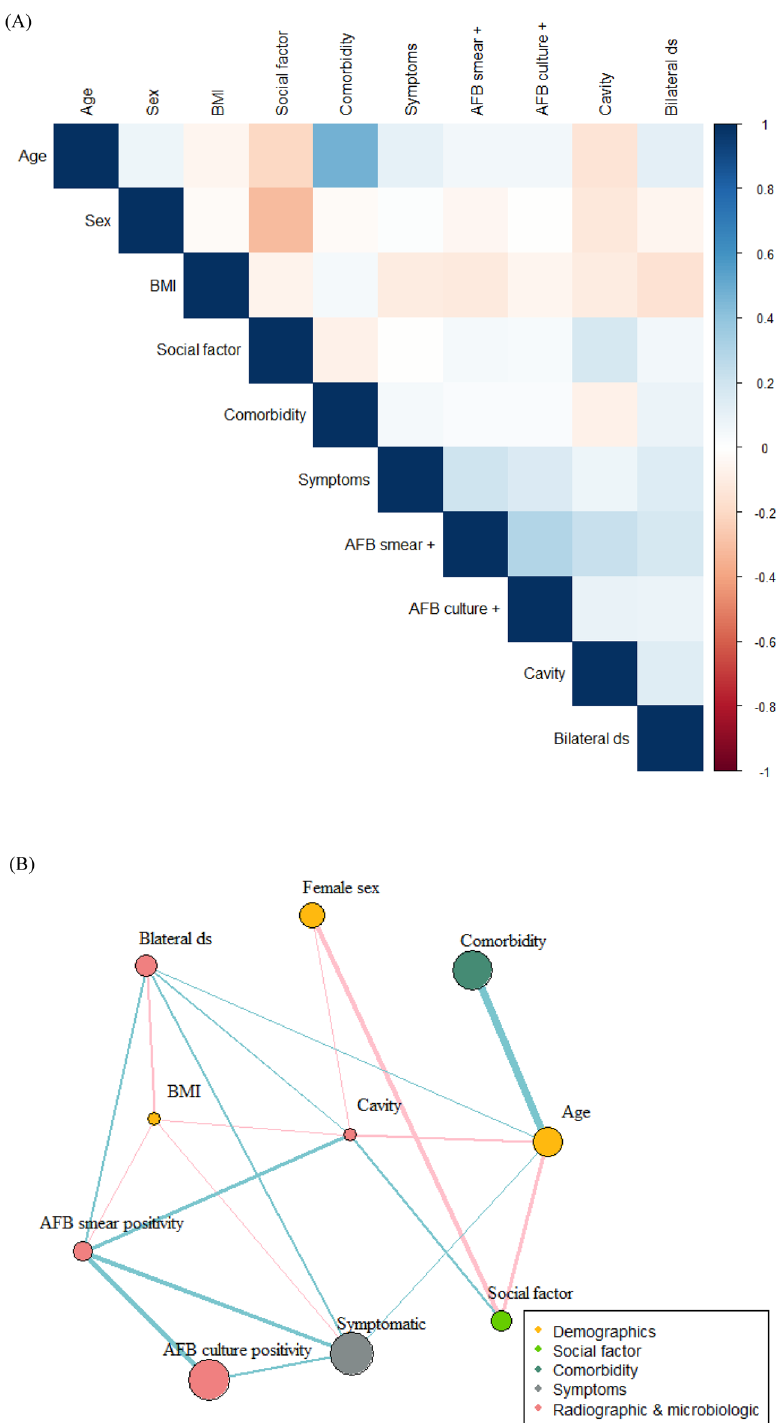
Figure 1. Correlation matrix ( A ) and correlation network ( B ) of variables. ( A ) Pearson correlation between variables was performed. Intensity of colour correlates with strength of their association. Colour of blue indicates positive correlation and that of red for negative correlation. ( B ) Links or edges between nodes indicate the existence of a statistically significant associations (P < 0.05). The thickness of edges correlated with the strength of their association (Pearson’s R coefficient): colour of blue for positive and that of pink for negative correlation. Social factor was defined as being at least one of smoker, drinker, and Medicaid subscriber. BMI, body mass index; AFB, acid-fast